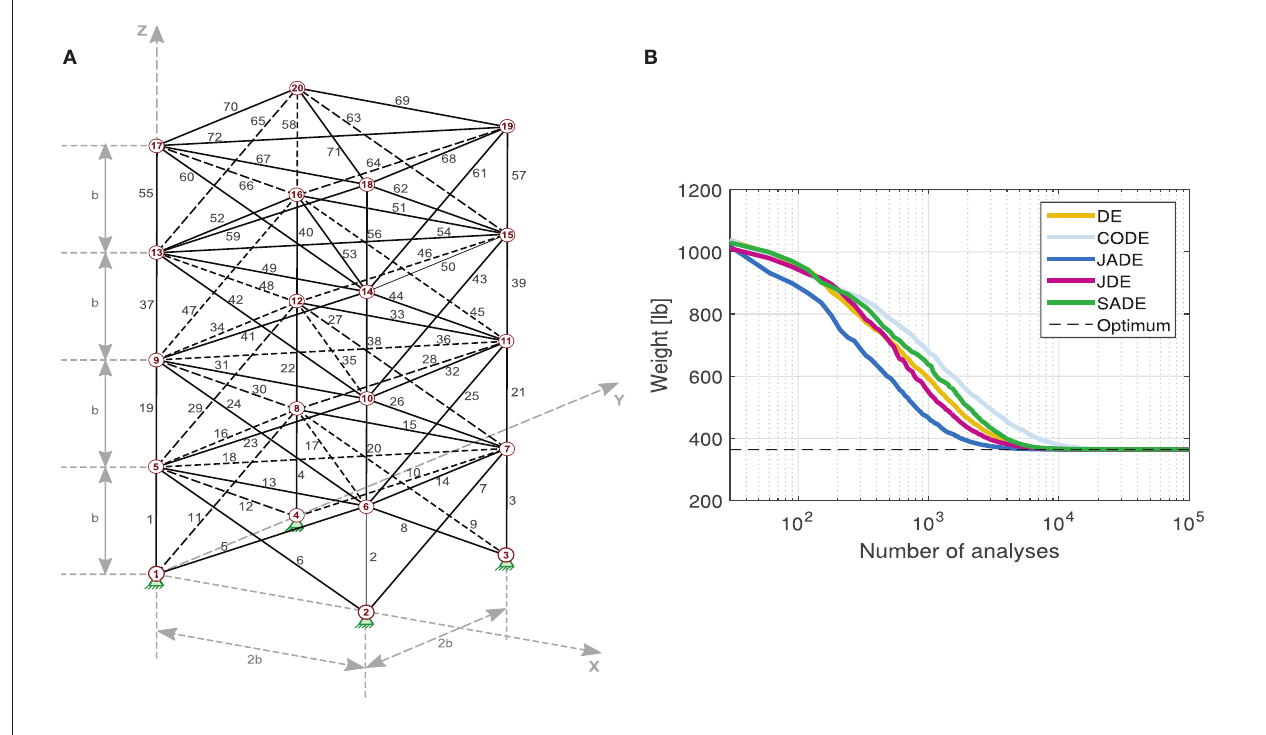
FIGURE 3 | 72-bar space truss (A) geometry; (B) algorithms’ convergence histories (average of 30 runs). TABLE 6 | Algorithms’ statistical parameters for the 72-bar space truss problem.